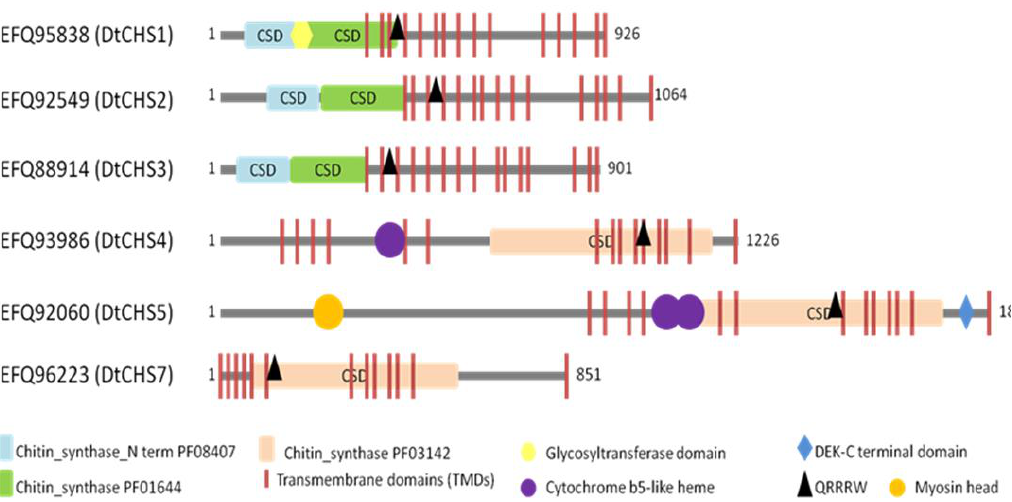
Figure 3. Schematic representation showing the domain organization of the six putative CHSs from D. teres . Highlighted motifs were identified with Motifscanner and predicted transmembrane domains were identified with Phobius and TMHMM programs. CSD: Chitin Synthase Domain.